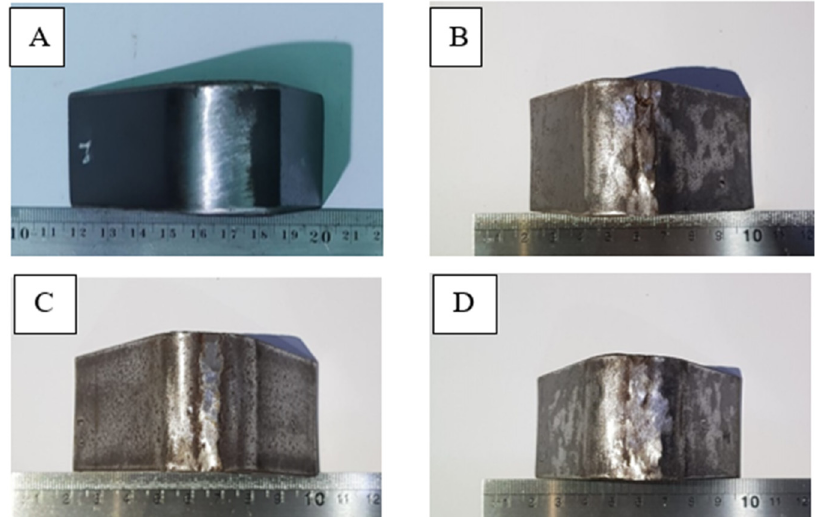
Figure 23. The results of the welding bending test ( A ) land-based welding, ( B ) underwater welding without flow, ( C ) underwater welding with the non-uniform flow and baffle plate, and ( D ) underwater welding with the non-uniform flow without a baffle plate.